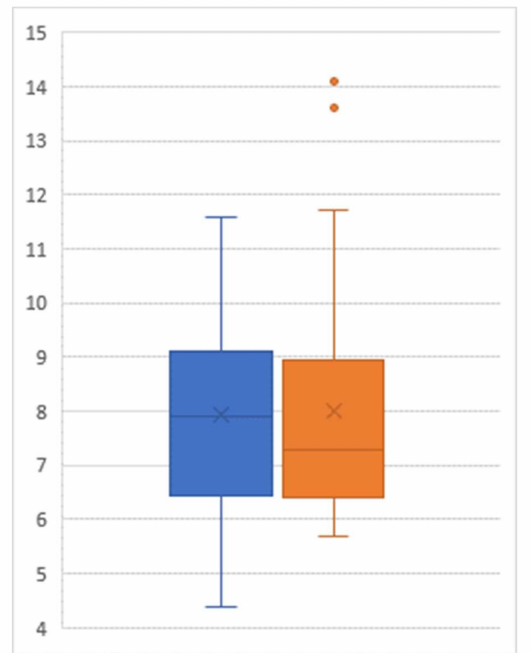
Figure 3. Box-and-whisker plot of hemoglobin A1C level (percent) post-intervention (left) and at follow-up (right); Sample size =